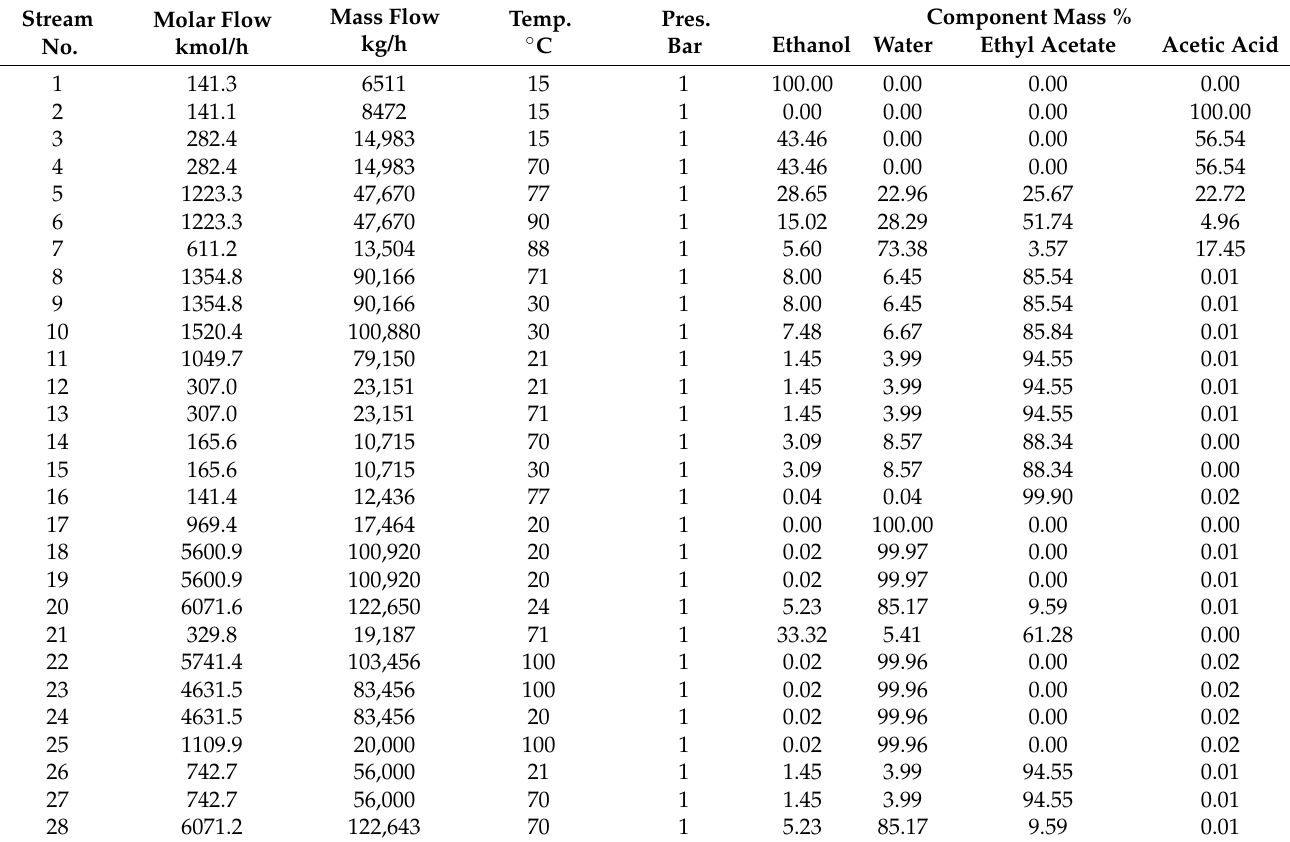
Table A1. Mass balance of the improved installation to produce EA, strategy 1 (S1).